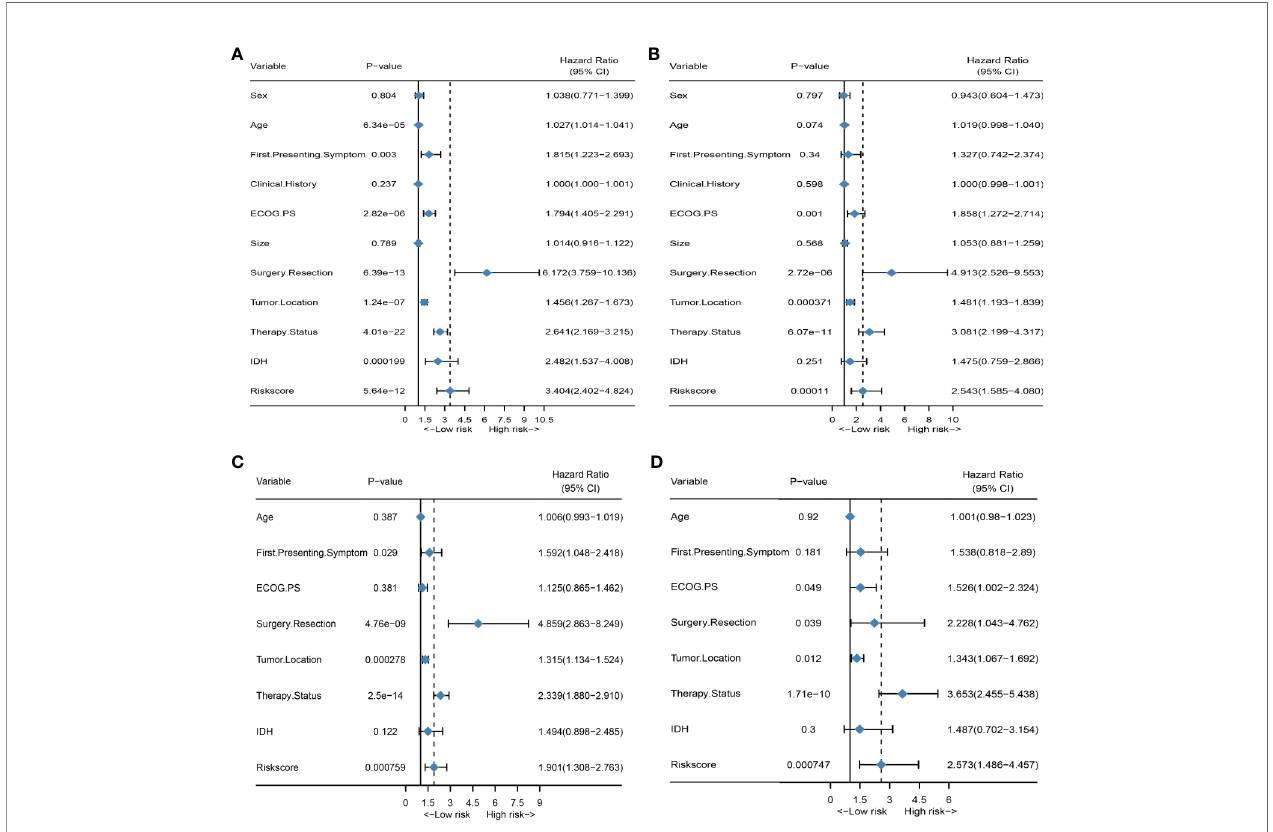
FIGURE 2 | HRS is an independent prognosis factor in both the training set and external validation set. (A) Forest plot of univariate Cox regression analysis of all clinical covariates in the training group; (B) Forest plot of univariate Cox regression analysis of all clinical covariates in the external validation group; (C) Forest plot of multivariate Cox regression analysis of all signi fi cant clinical covariates in the training group; (D) Forest plot of multivariate Cox regression analysis of all signi fi cant clinical covariates in the external validation